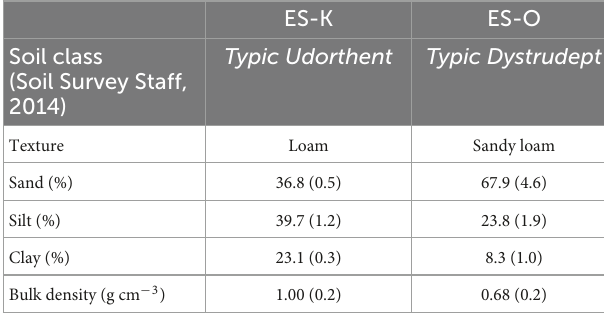
TABLE 2 General characterization of the soil in each experimental site of Karrantza and Oiz (ES-K and